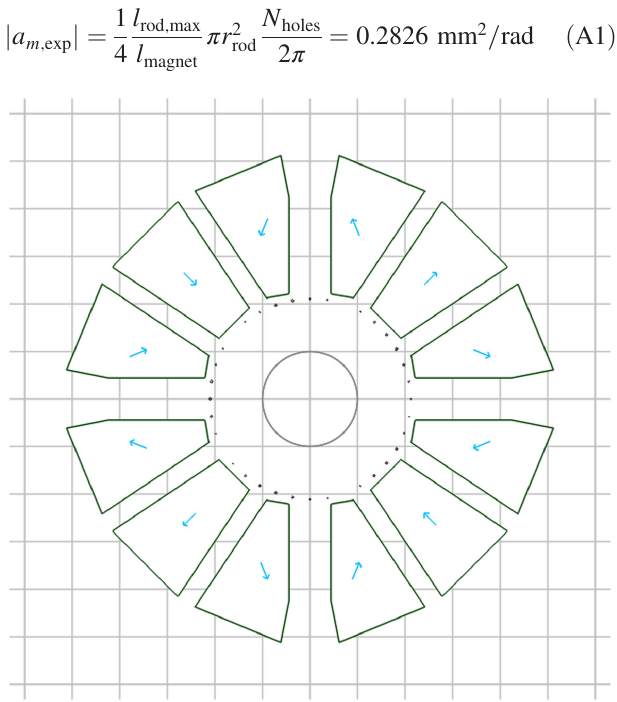
FIG. 14. Current sheet model of permanent magnet quadrupole “ 5A ” with correction rod locations and 1 cm radius circle shown at